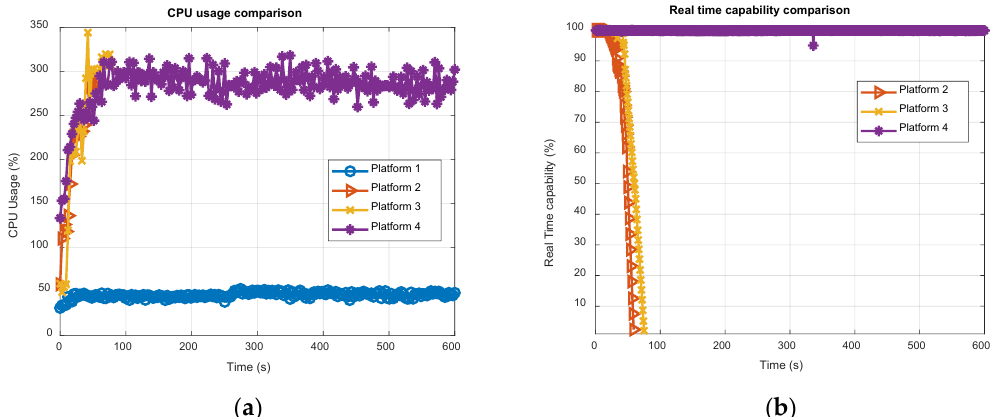
Figure 10. Time evolution of the CPU usage on the four platforms ( a ) and real-time capability of eNGene receiver on the three embedded platforms ( b ) for 16 satellites, i.e., 6 GPS and 6 Galileo, simultaneously tracked.